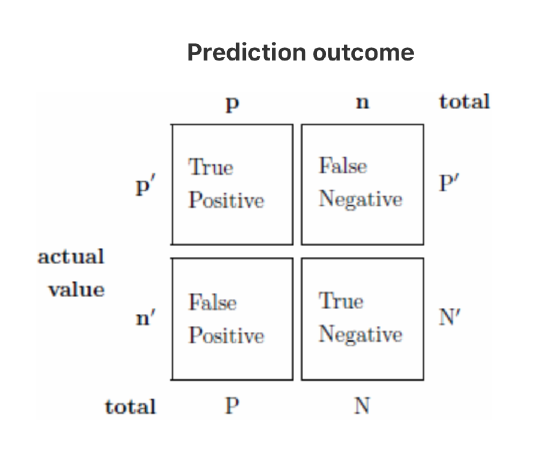
Figure 6. Binary classification confusion